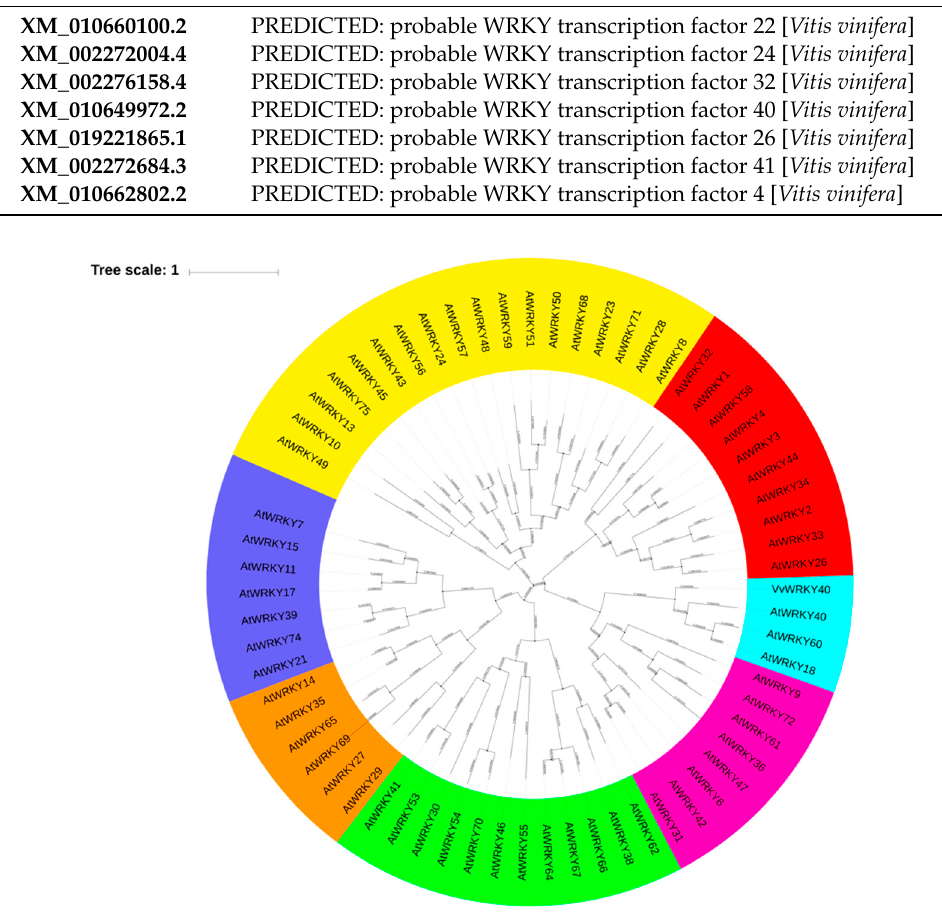
Figure 4. Neighbor-joining phylogenetic tree constructed from the deduced amino acid sequences of VviWRKY40 and other WRKY family transcription factors from Arabidopsis retrieved from the NCBI’s RefSeq database using MEGA 5.20.